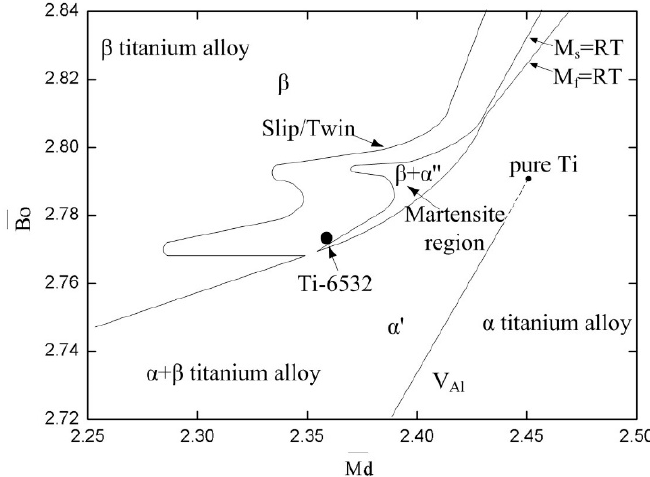
Figure 1. The position of the alloy in Bo – Md diagram.